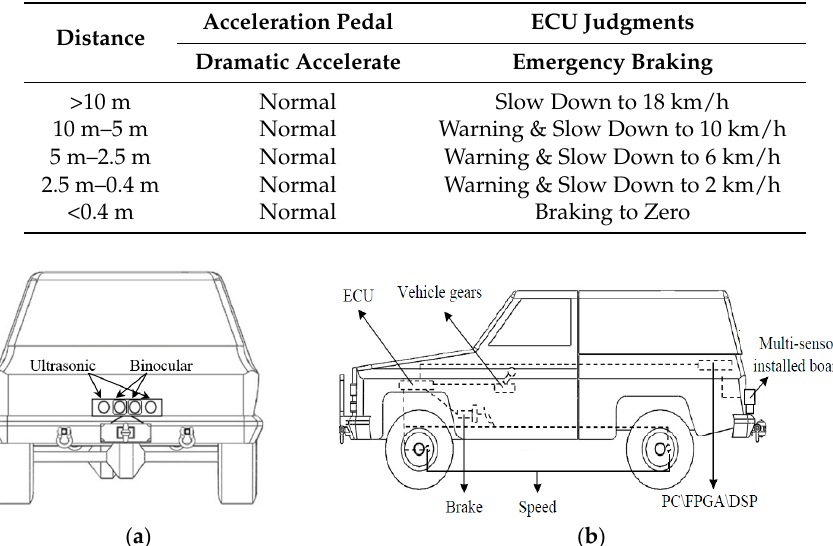
Table 1. Various judgments of ECU under different conditions.